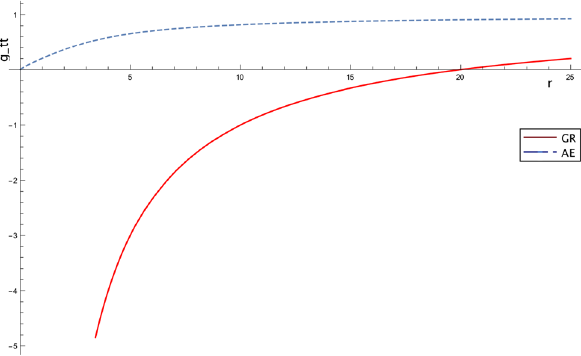
Fig. 8 Plotofthemetriccomponent g tt ,forEAparameters c 14 = − 16, | κ | = 1 and an arbitrary Schwarzschild mass M = 10. The continuous red line represents the GR Schwarzschild metric. The dashed blue line represents the EA solution. Calculating the limit r → +∞ , we obtain g tt = e 2 A → 1, as we can see in this figure. Calculating the limit from right r → r sing 1 = 0 we obtain g tt = e 2 A → 0, as we can see in this figure